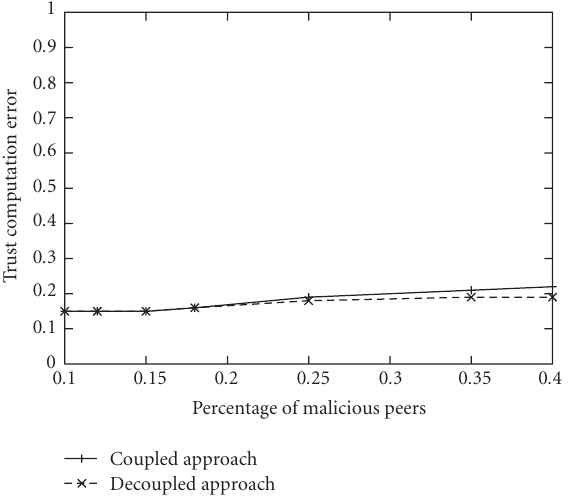
Figure 9: Trust computation error with respect to percentage of malicious peers.